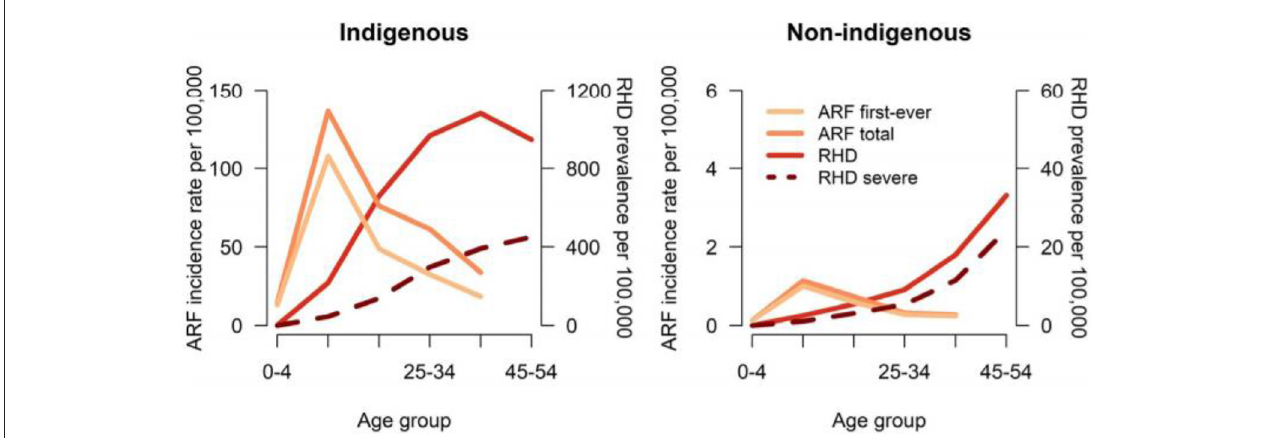
FIGURE 3 | Age-specific incidence of ARF and prevalence of RHD in 5 Australian jurisdictions, by Indigenous status, 2015 to 2017. ARF total includes first-ever episodes of ARF plus ARF recurrences. Severe RHD includes RHD cases who were recorded as having been in heart failure, received at least 1 cardiac valvular intervention or were recorded on RHD register as being severe. ARF or RHD includes any live person with a history of either ARF or RHD. ARF, acute rheumatic fever; RHD, rheumatic heart disease (46).